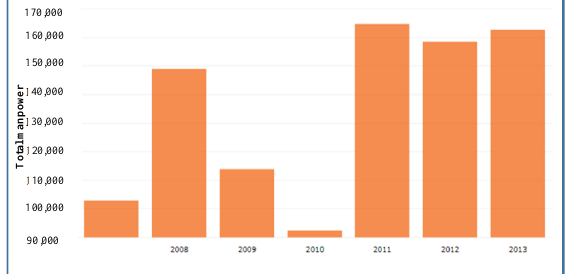
Figure 9. Number of workers in the industrial sector in Cilacap (Katadata team,